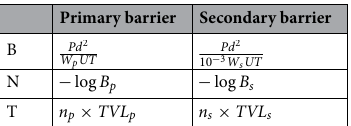
Table 2. Parameter formulas for the primary and secondary beam.